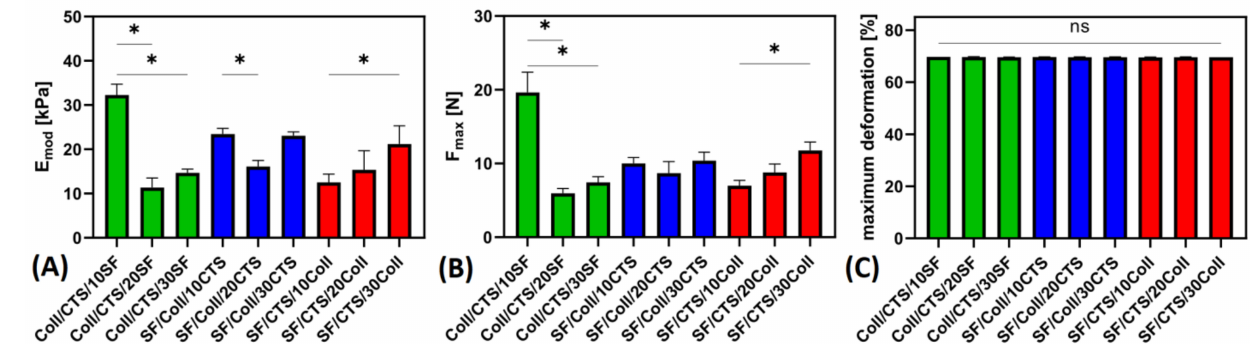
Figure 12. The results of mechanical properties studies of biopolymeric scaffolds, cross-linked by EDC/NHS: ( A ) Young’s modulus; ( B ) maximum force; ( C ) maximum deformation; *—represents statistically significant differences between samples ( p ≤ 0.05); ns—represents no statistically significant differences ( p ≤ 0.05).